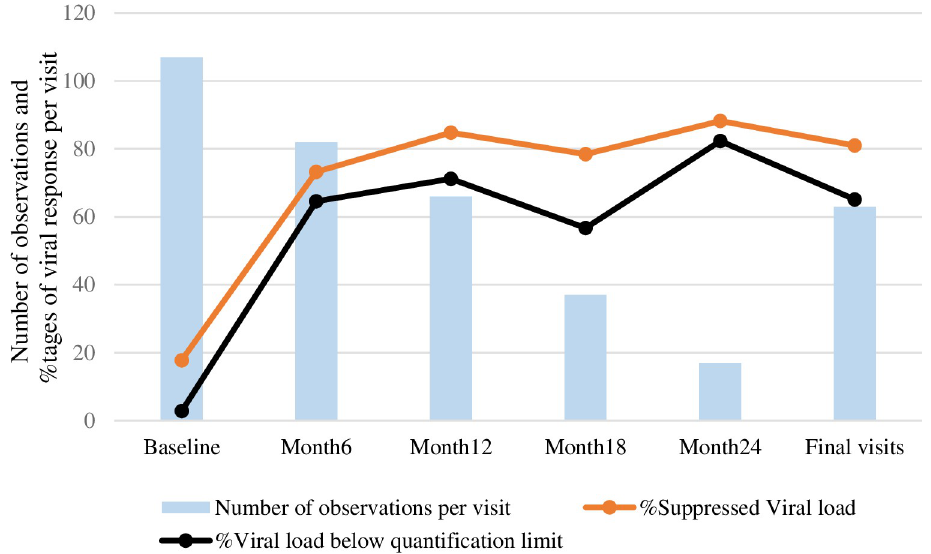
Fig 2. Time trends in suppressed and below quantification limit viral load among HIV-infected FSWs on ART, Benin. N: Number of observations per visit % Suppressed viral load : Proportion of participants with viral load < 1000 copies/ml % Below quantification limit : Proportion of participants with viral load < 50 copies/ml Final Visits : Included 63 participants with regular final visits from Month 6 onwards; excluded all final visits that occurred prior to